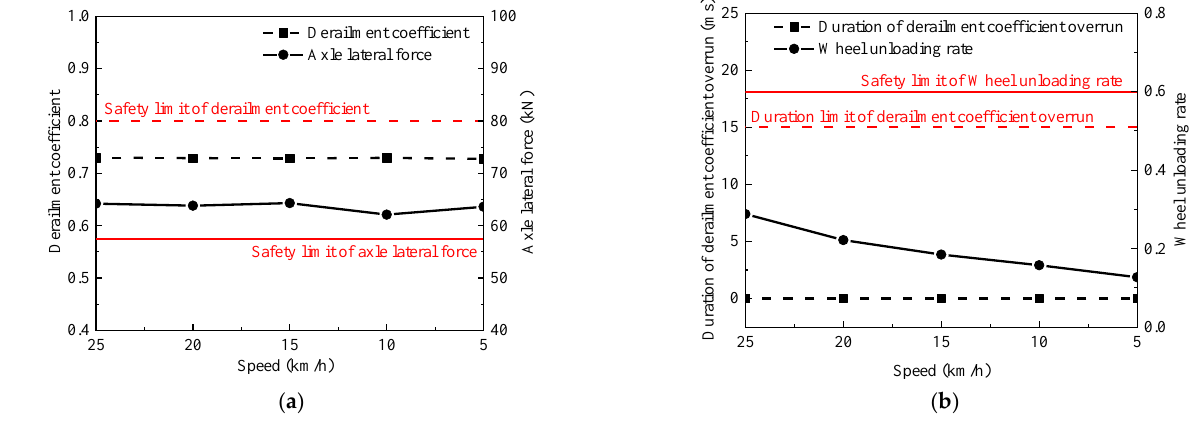
Figure 18. Operation safety indices vs. train running speed under extreme wear conditions: ( a ) de- railment coefficient and axle lateral force; ( b ) duration of derailment coefficient overrun and wheel unloading rate.